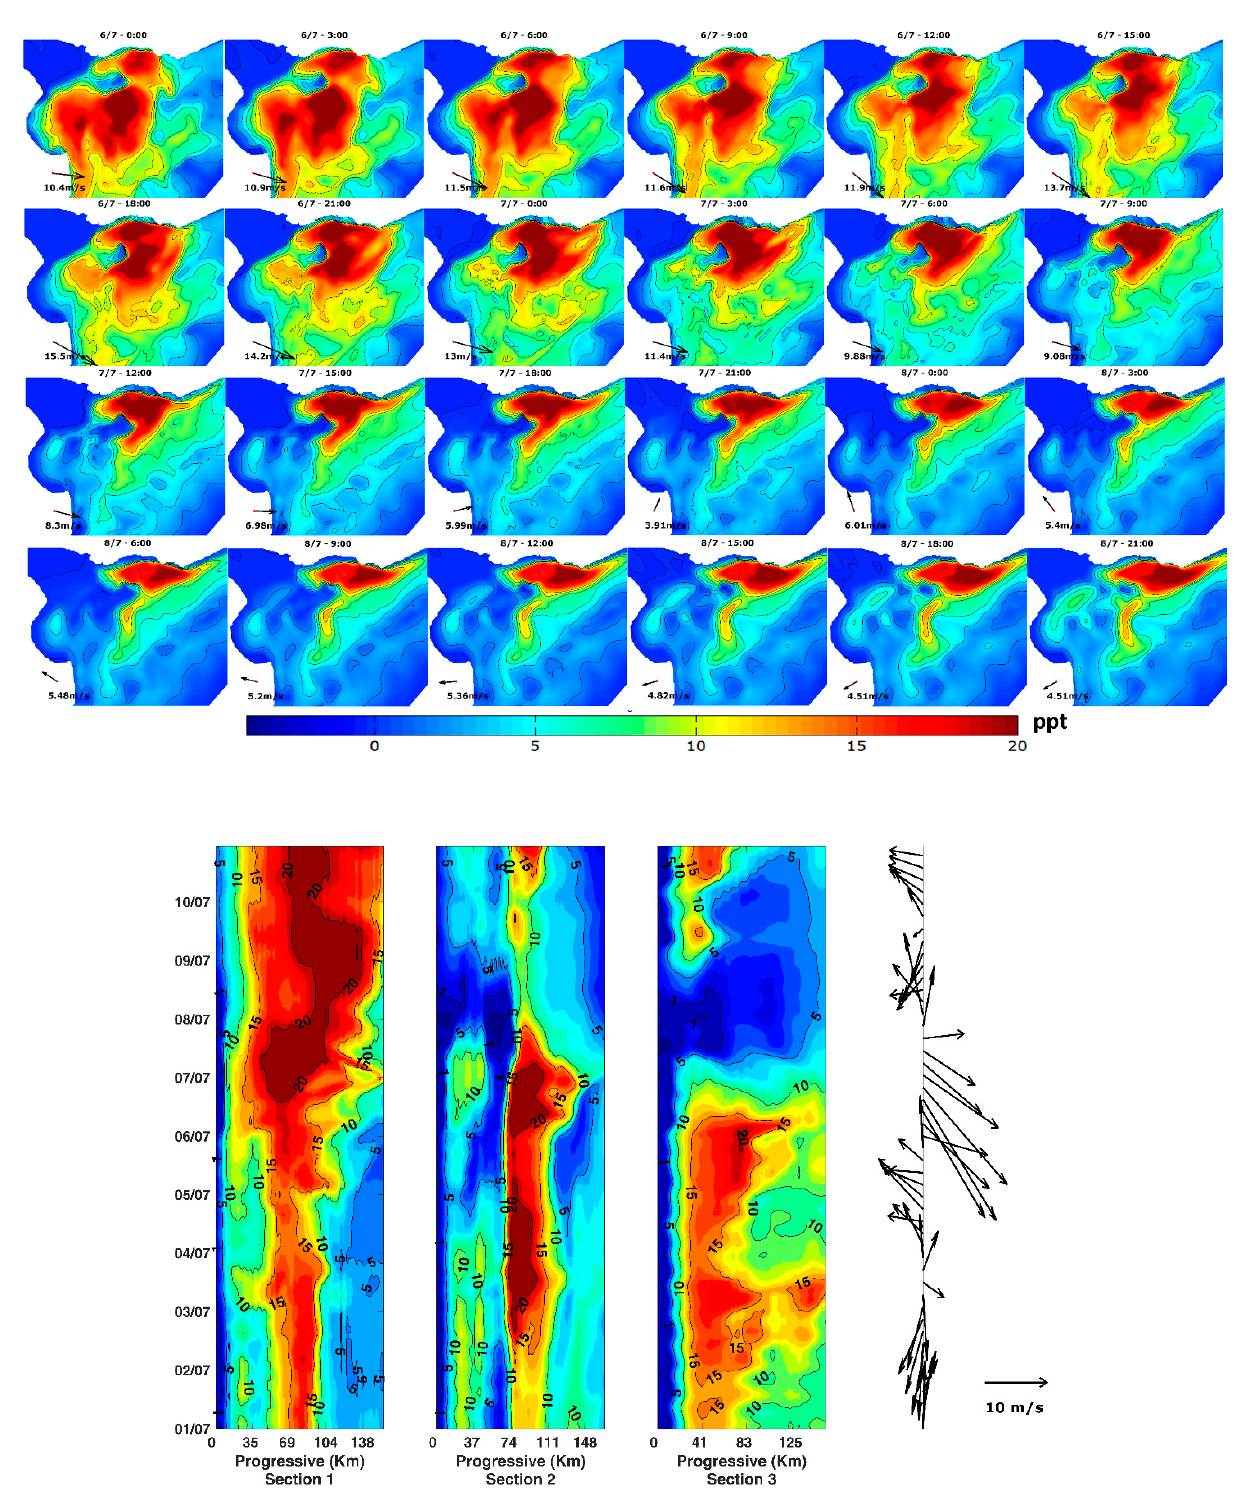
Figure 10. Stratification for a storm with main wind direction from the northwest, which occurred in July 2014. Upper panel: temporal evolution of the stratification field (ppt; time step: 3 h). Time increasing from left to right and upper to lower panels. All maps are in geographic coordinates between Lat ( − 36.9, − 34.7) and Long ( − 57.4, 54.2). Lower panel: Hovmoller diagram along longitudinal sections (Figure 7); wind evolution on the right. Y-axis shows the date (dd/mm).